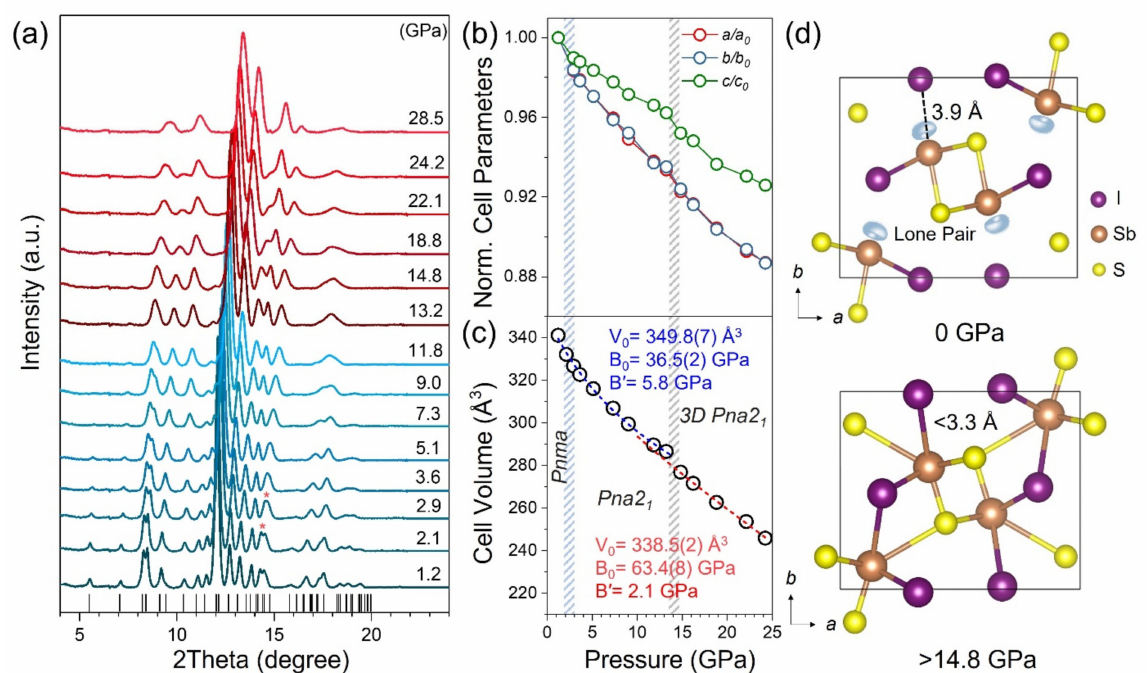
Figure 1. Pressure-induced structural evolution of SbSI. ( a ) Comparison of SbSI XRD at different pressures. ( b ) The lattice constants fitting by the Rietveld method and ( c ) the unit-cell volume as a function of pressure. ( d ) The crystal structures at 0 and 22.8